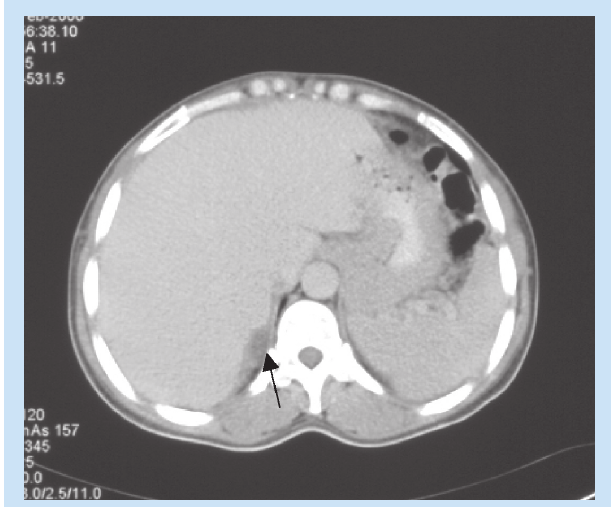
Fig. 1. Axial venous phase CT demonstrates a low-density area in the region of the right adrenal gland suggestive of a possible mass.